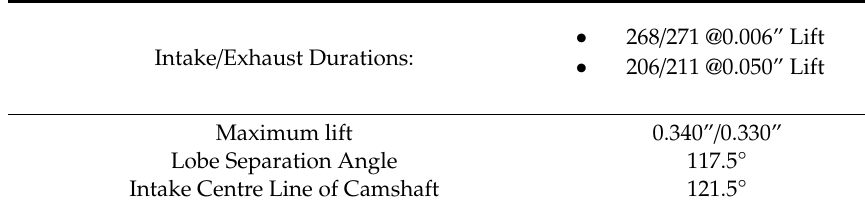
Table 1. Specification of the Camshaft.